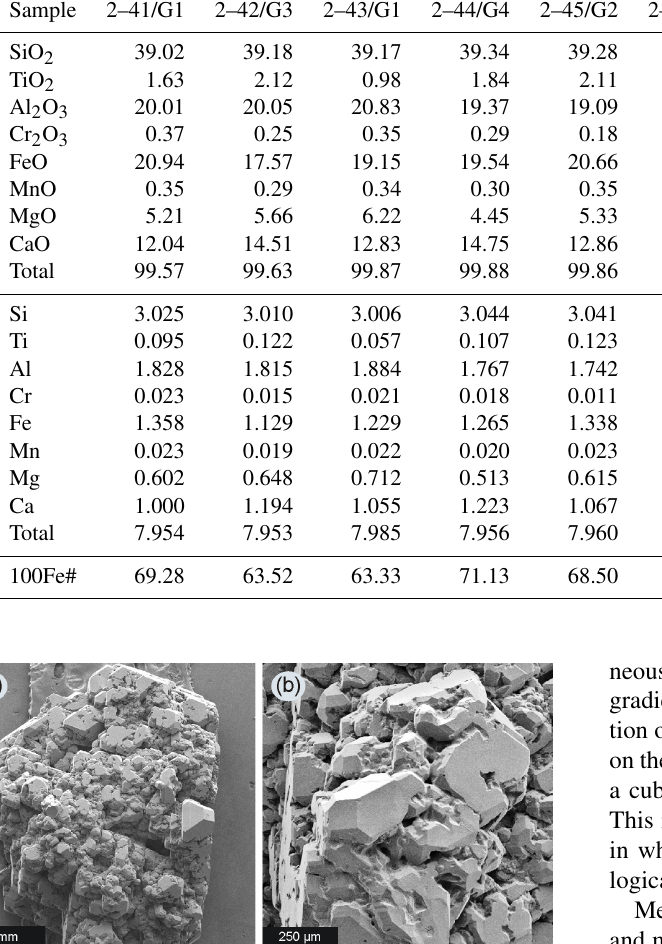
Table 2. Representative chemical analyses of garnet from the experiments. Sample